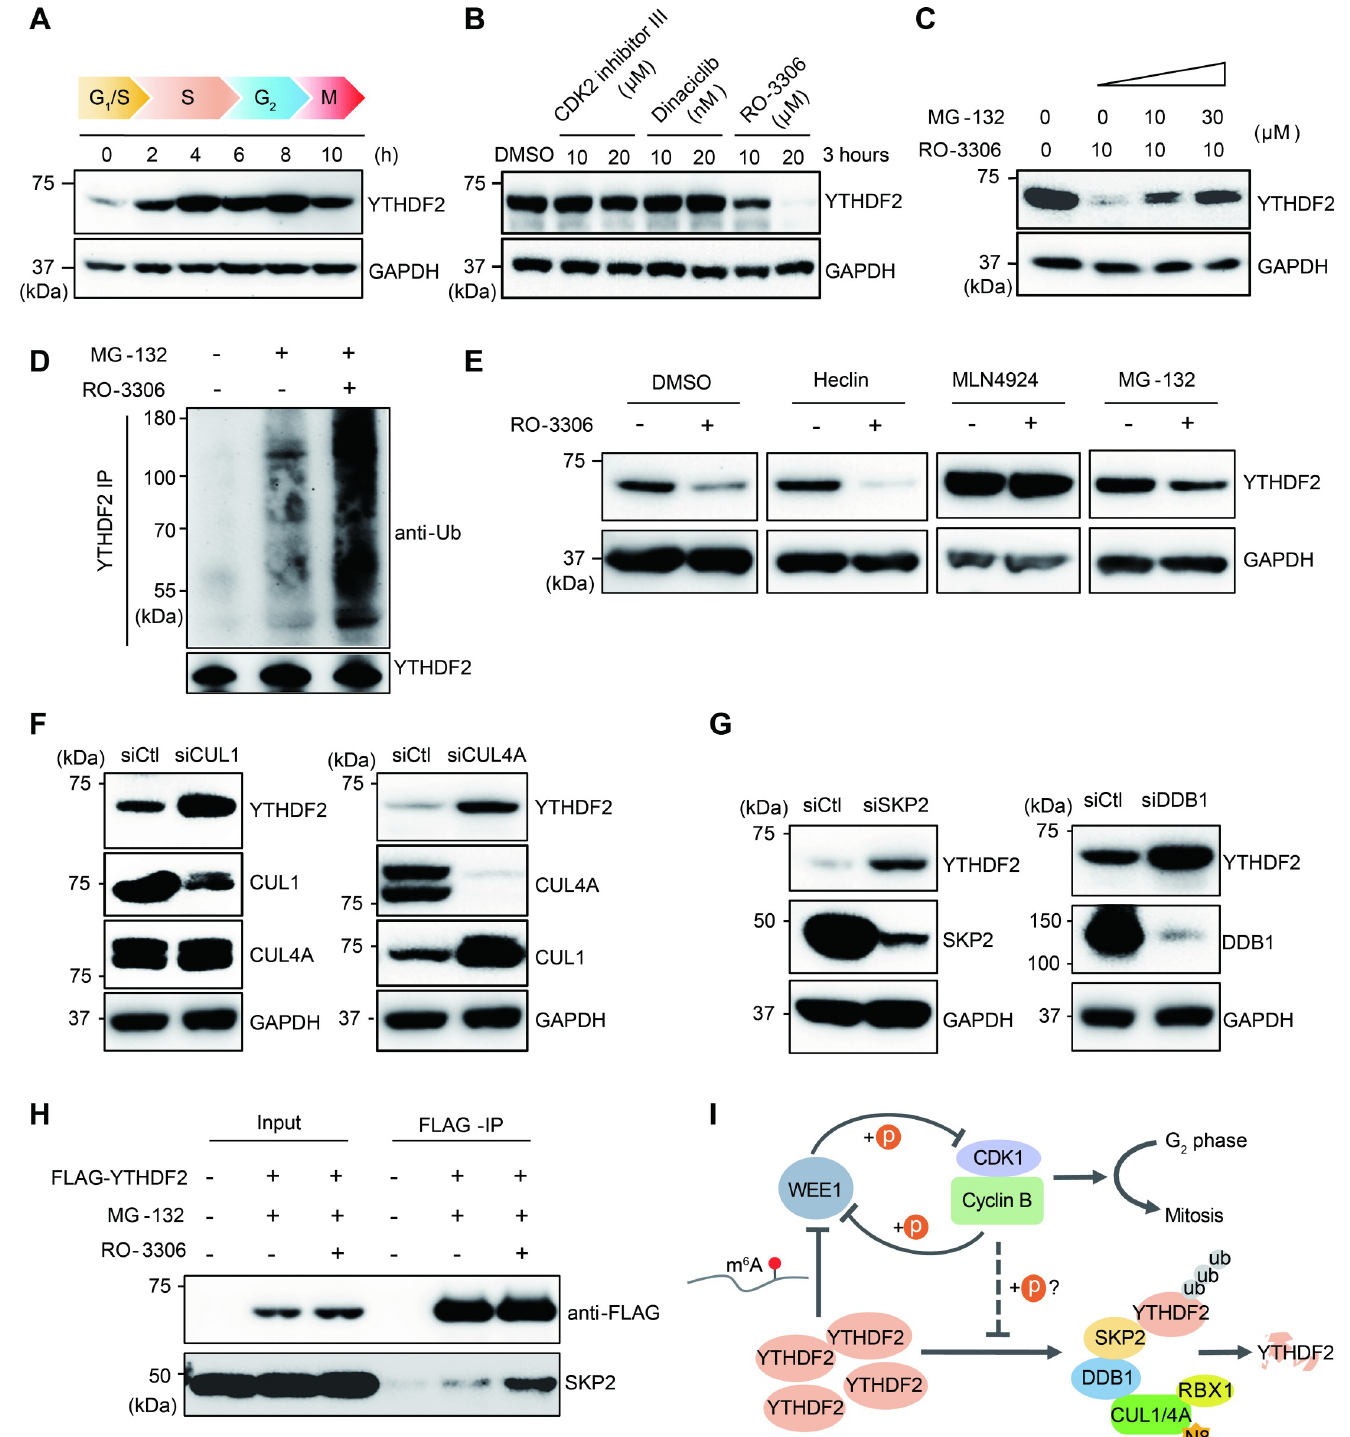
Fig 4. YTHDF2 stability is dependent on CDK1 activity. (A) Western blot of YTHDF2 post G 1 /S synchronization. Samples were collected at the indicated hours post release. (B) Western blot of YTHDF2 using cells treated with small molecule inhibitors. Cells were treated with CDK2 inhibitor III, dinaciclib, and the CDK1 inhibitor RO-3306 in different concentrations as indicated for 3 hours. (C) Western blot of YTHDF2 using cells pretreated with the proteasome inhibitor MG-132 before the CDK1 inhibitor RO-3306 treatment. Cells were incubated with MG-132 with indicated concentrations for 3 hours before RO-3306 treatment. (D) YTHDF2 IP followed by western blot with ubiquitin antibody and YTHDF2 antibody. Cells were pretreated with MG-132 3 hours before being incubated for 3 hours with RO-